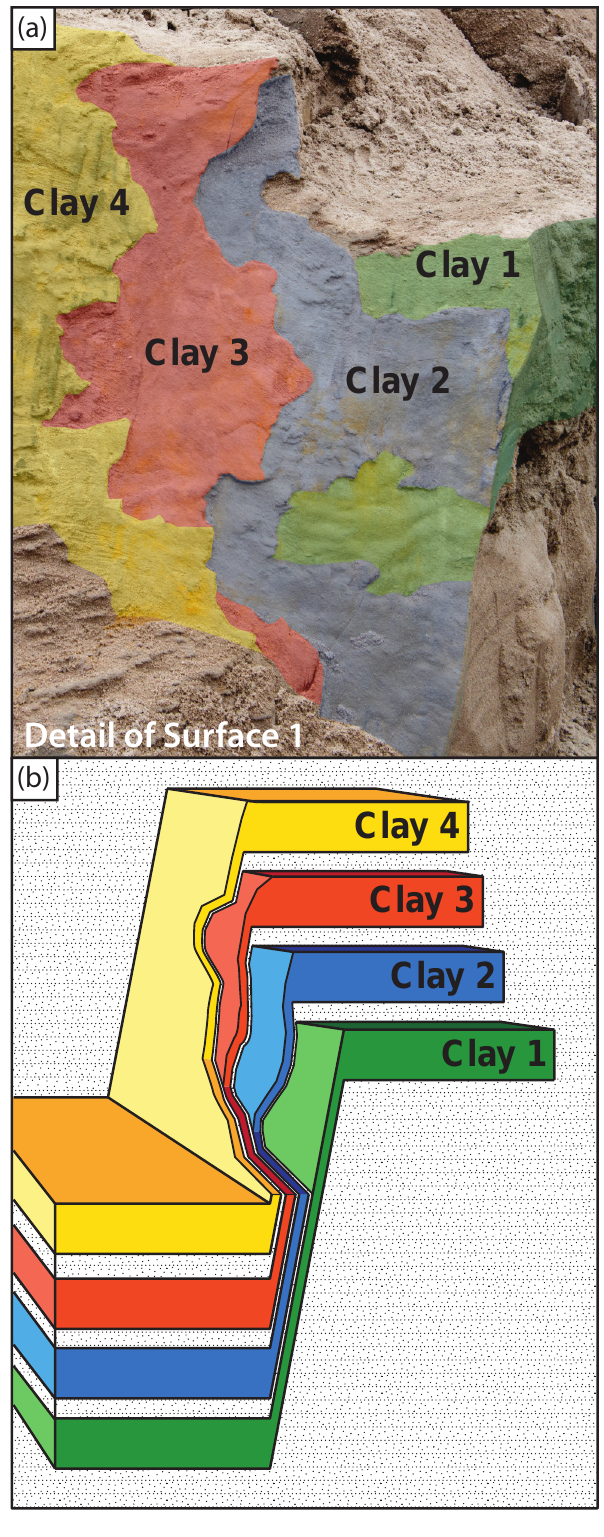
Figure 6. (a) Detail of the SE side of surface 1 showing multiple thin clay veneers composing the bulk clay smear. Colours added manually to distinguish different clay layers. (b) Sketch illustrating the layering of clay smear with interbedded sand